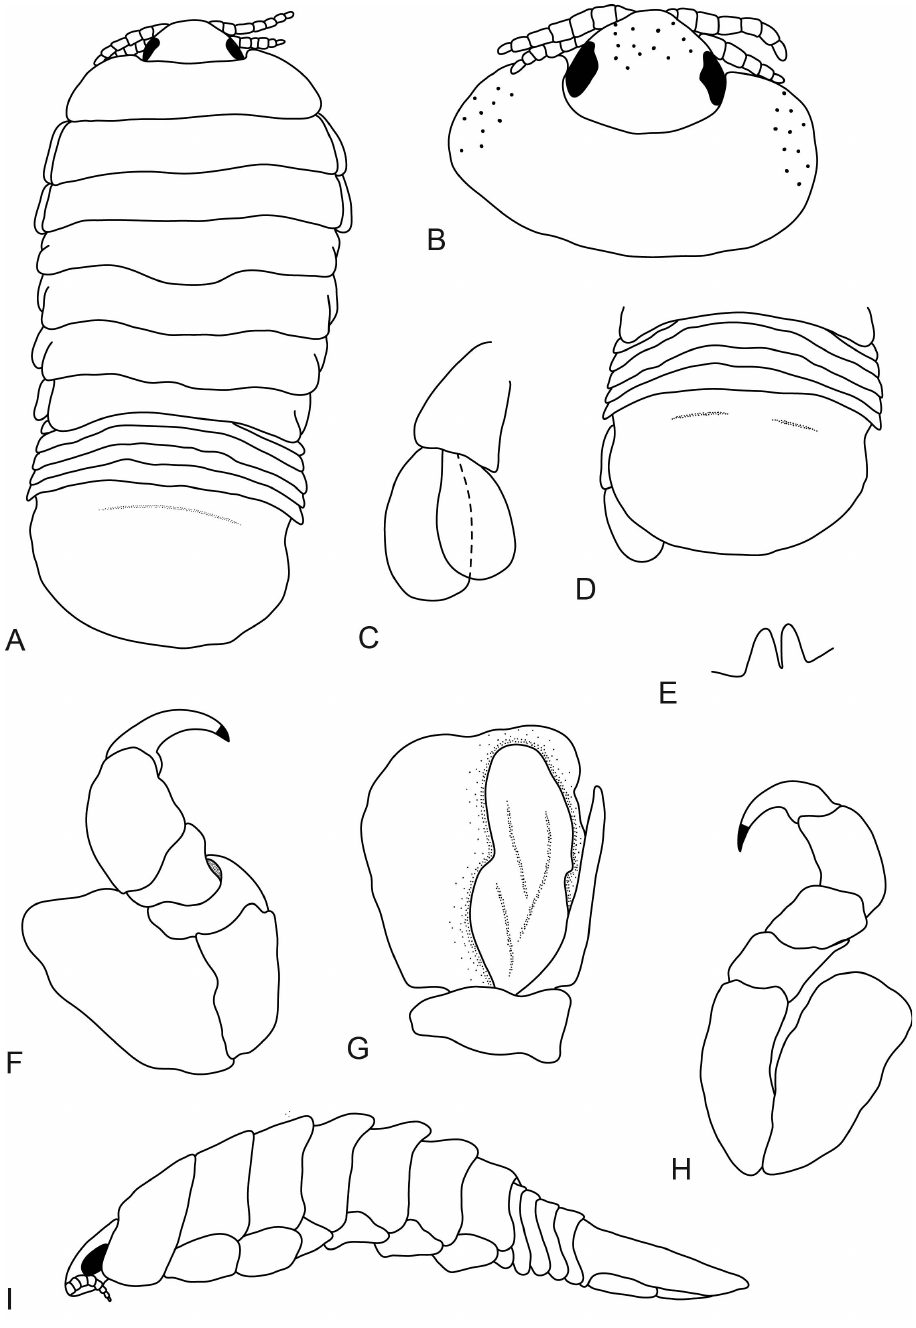
Figure 4. Elthusa winstoni sp. n., male paratype (8 mm) (AMNH_IZC 250218). A dorsal view B dorsal view of pereonite 1 and cephalon C uropod D dorsal view of pleotelson E penes F pereopod 1 G pleopod 2 with appendix masculina H pereopod 7 I lateral